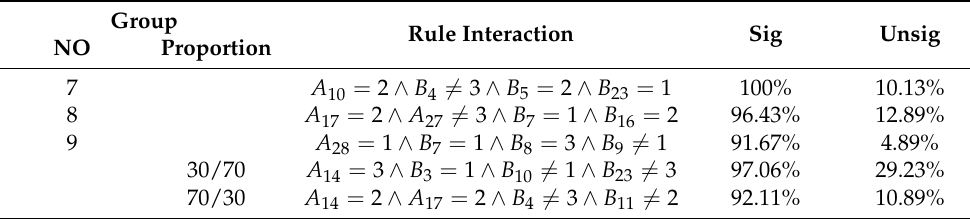
Table 5. Rule interactions found by using FPM for each of the scenarios from the initial optimization.